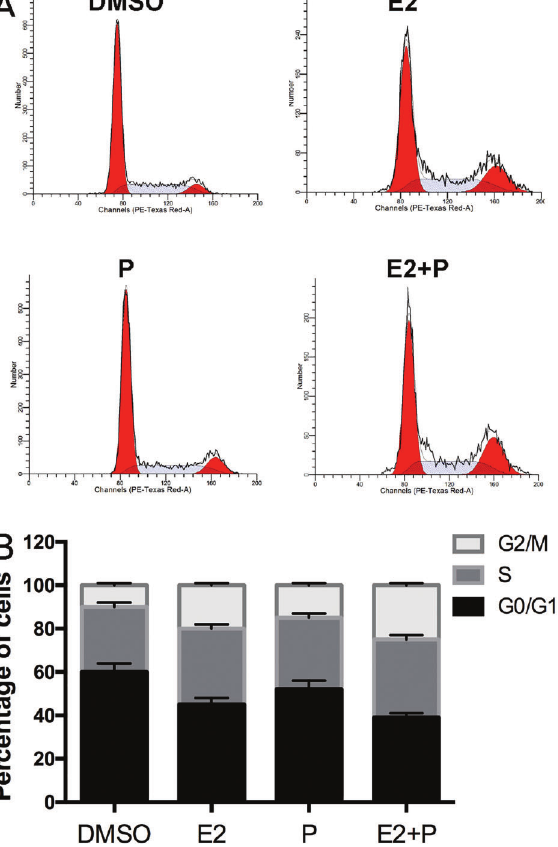
Figure 3. A , Effect of estradiol (E2) and progesterone (P) treat- ments on cell cycle progression. B , Cell accumulation in the G2/M phase of the cell cycle with each treatment. DMSO was used as control. Data are reported as means ± SD.